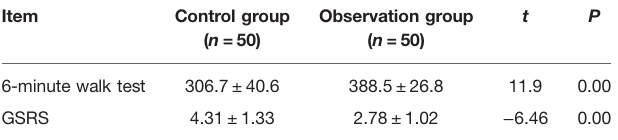
TABLE 4 | The 6-minute walk test and PG-SGA score of the two groups at discharge.